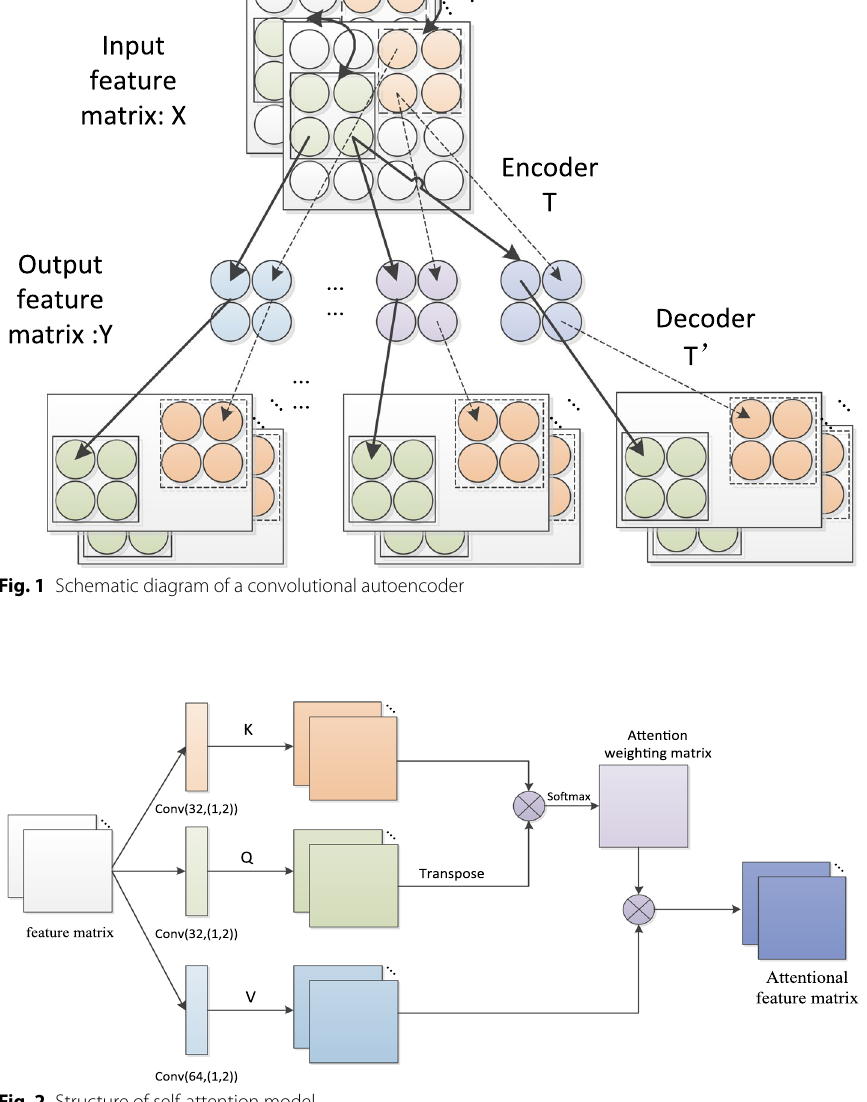
Fig. 2 Structure of self-attention